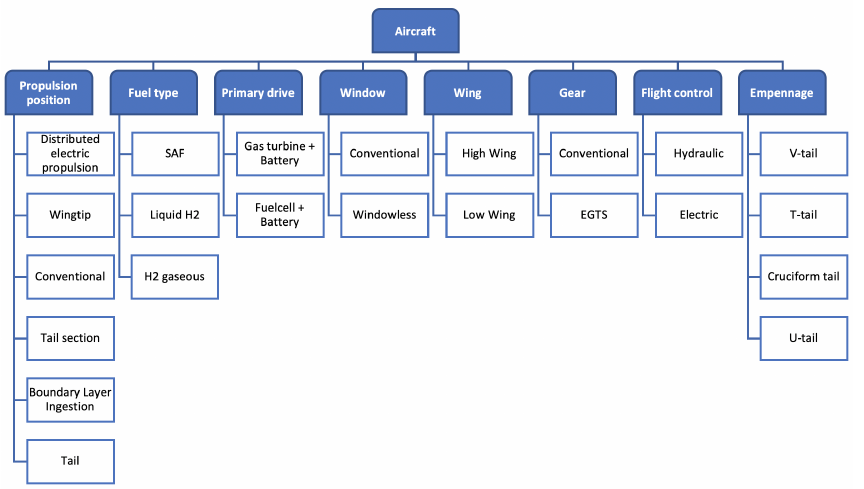
Figure 2. All investigated design possibilities listed by their